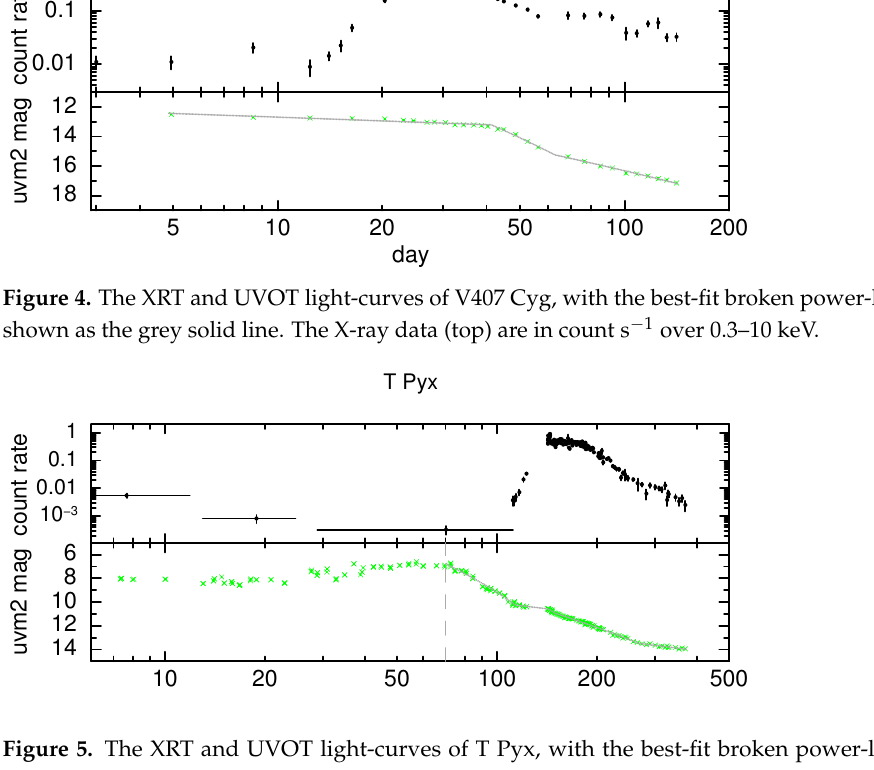
Figure 5. The XRT and UVOT light-curves of T Pyx, with the best-fit broken power-law decline shown as the grey solid line. Only data after the UV peak on day 70 (marked with the vertical dashed line) were considered. The observations of T Pyx are plotted as days since discovery; the optical peak occurred around 28 days later. The X-ray data (top) are in count s − 1 over 0.3–10 keV.